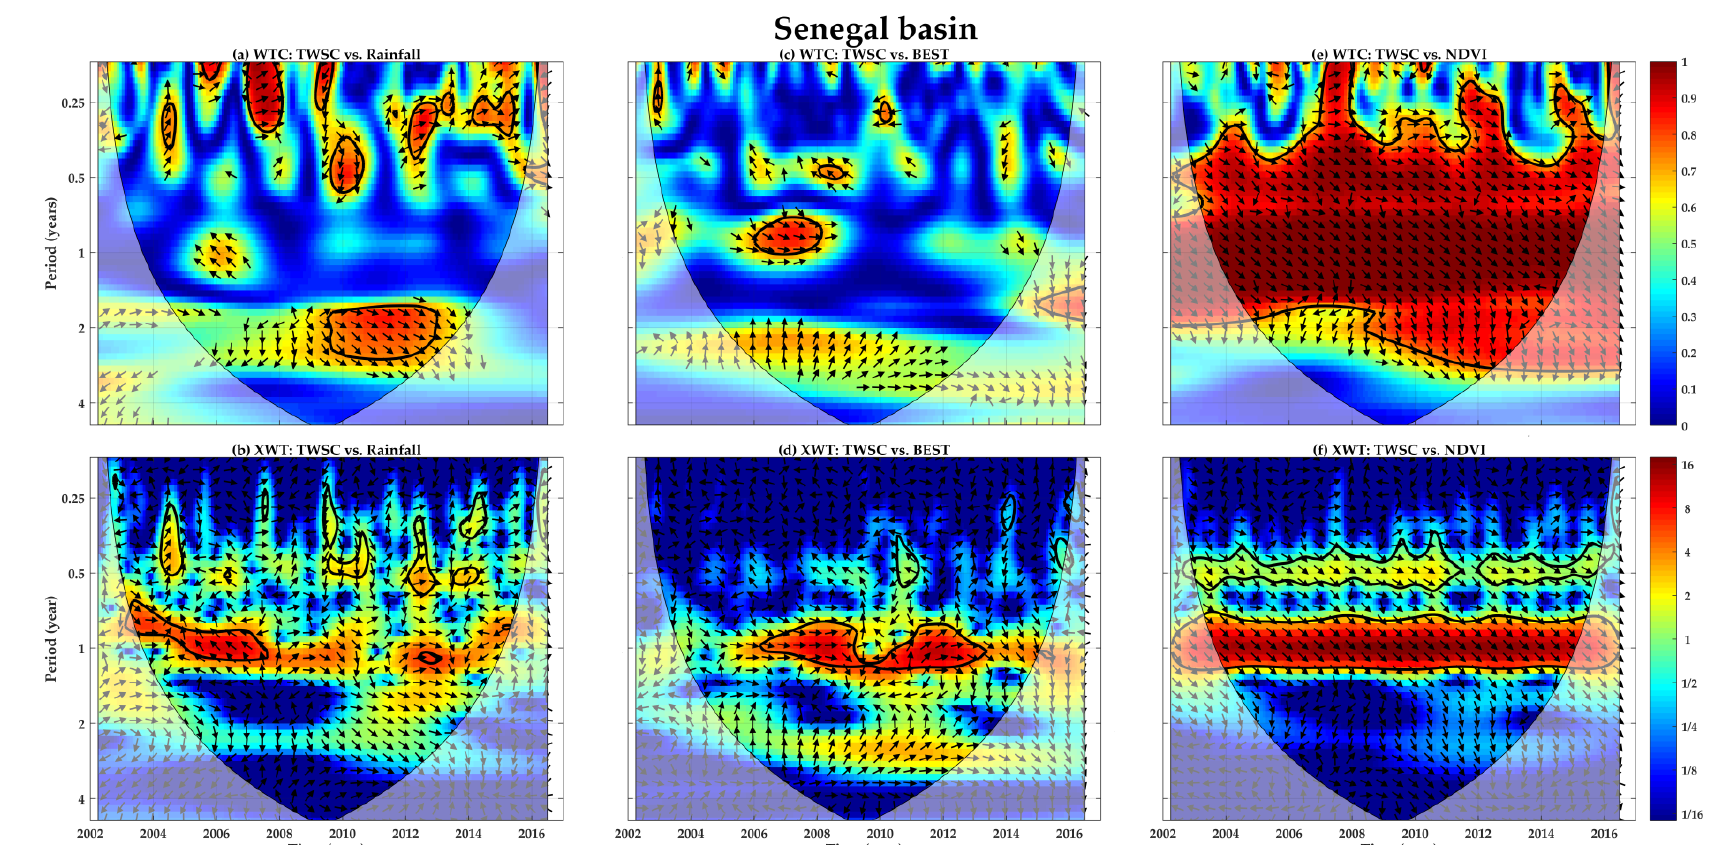
Figure 12. WTC and the corresponding XWT showing the interactions between the regional TWSC of the Senegal Basin and: the TRMM rainfall ( a , b ), the BEST ( c , d ), and the NDVI ( e , f ). Black contour lines indicate the 95% confidence level against the red noise between the variables, while the shaded cone represents the cone of influence (COI). The relative phase relationships are denoted by arrows designating phase difference between two variables A and B. The phase arrows pointing right ( → ) depict the in-phase, those pointing left ( ← ) depict the anti-phase, those pointing down ( ↓ ) indicate that A is leading B by 90°, and those pointing up ( ↑ ) indicate that B is leading by 90°.